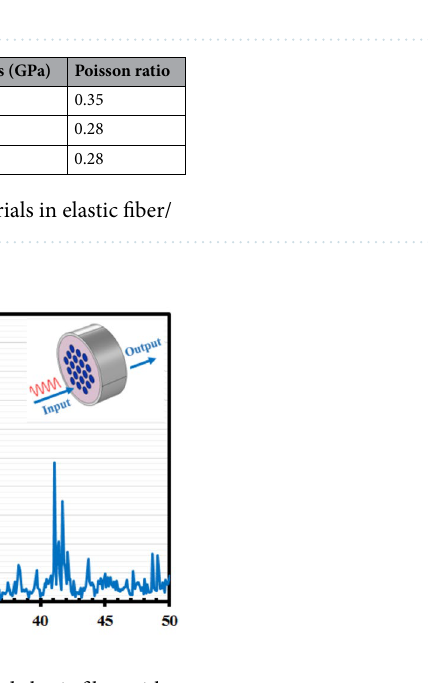
Figure 3. Transmission spectrum of proposed elastic fiber without